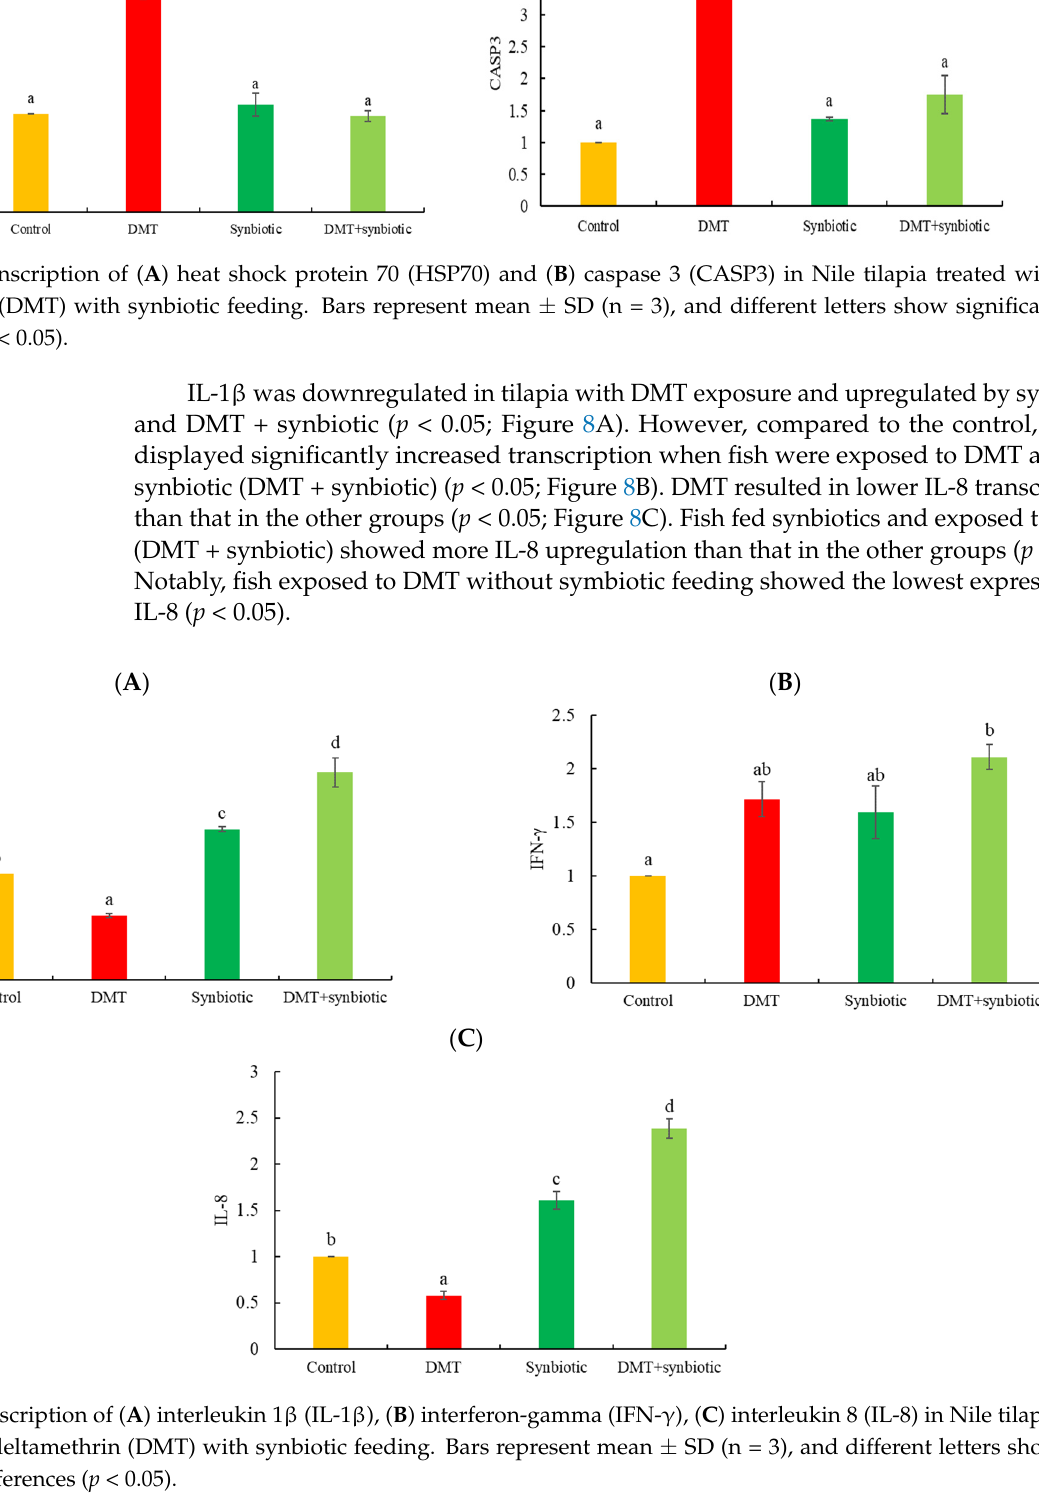
Figure 6. Transcription of antioxidative genes: ( A ) catalase (CAT) and ( B ) glutathione peroxidase (GPx) in Nile tilapia treated with deltamethrin (DMT) with synbiotic feeding. Bars represent mean ± SD (n = 3), and different letters show significant differences ( p < 0.05).